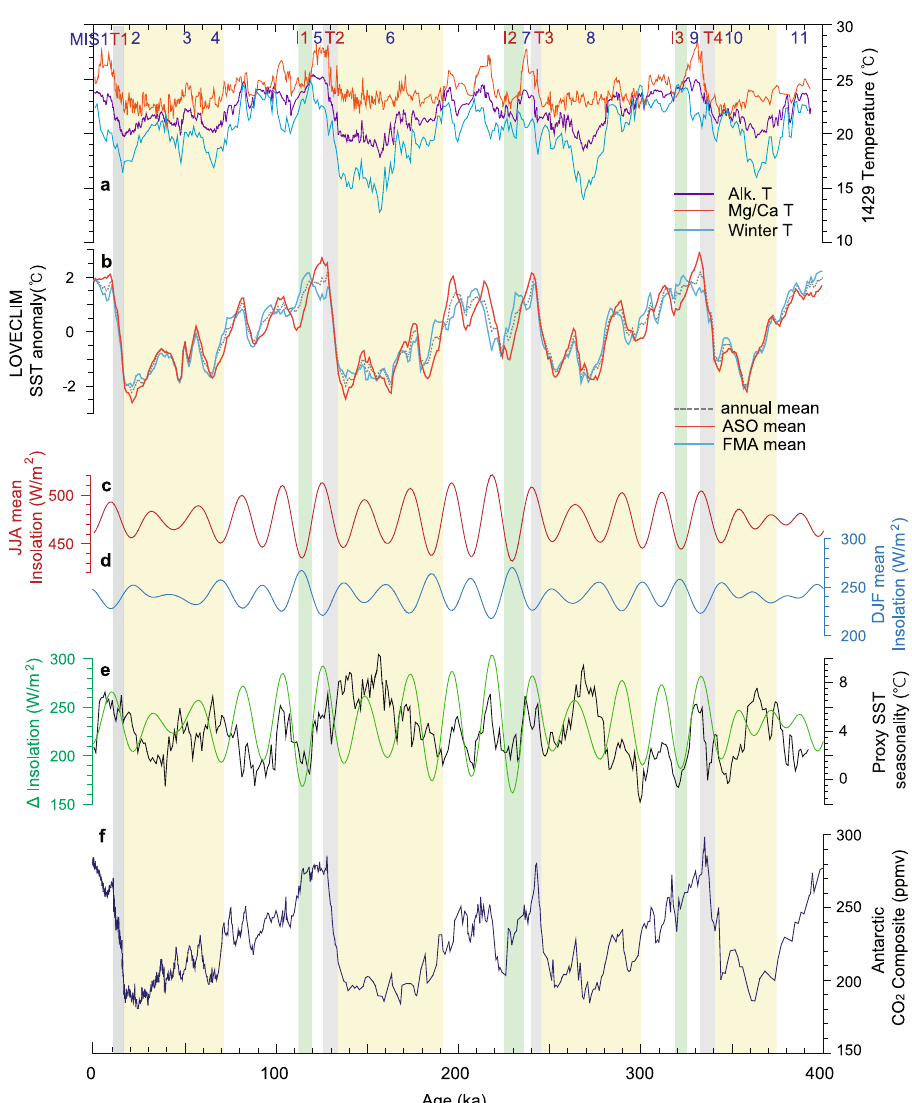
Fig. 4 Time series of annual mean and seasonal sea surface temperatures (SST) and seasonality. a Comparison of G. ruber Mg/Ca-based summer temperature, alkenone-based annual mean temperature, and estimated winter temperature at Site U1429 over the past 400 kyr. b Seasonal temperatures from a transient LOVECLIM earth system model simulation 35 . c Summer (June − August) mean insolation at the latitude of Site U1429. d Winter (December − February) mean insolation at the latitude of Site U1429. e Difference in insolation between June − August and December − February and proxy SST seasonality (summer temperature minus winter temperature) variation. f Antarctic composite CO 2 concentration 49 . Yellow, grey, and green shaded areas indicate the glacial period, termination, and inception, respectively. Glacial inception periods are denoted as I1, I2, and I3 3 , and glacial termination periods are indicated as T1, T2, T3, and T4 23